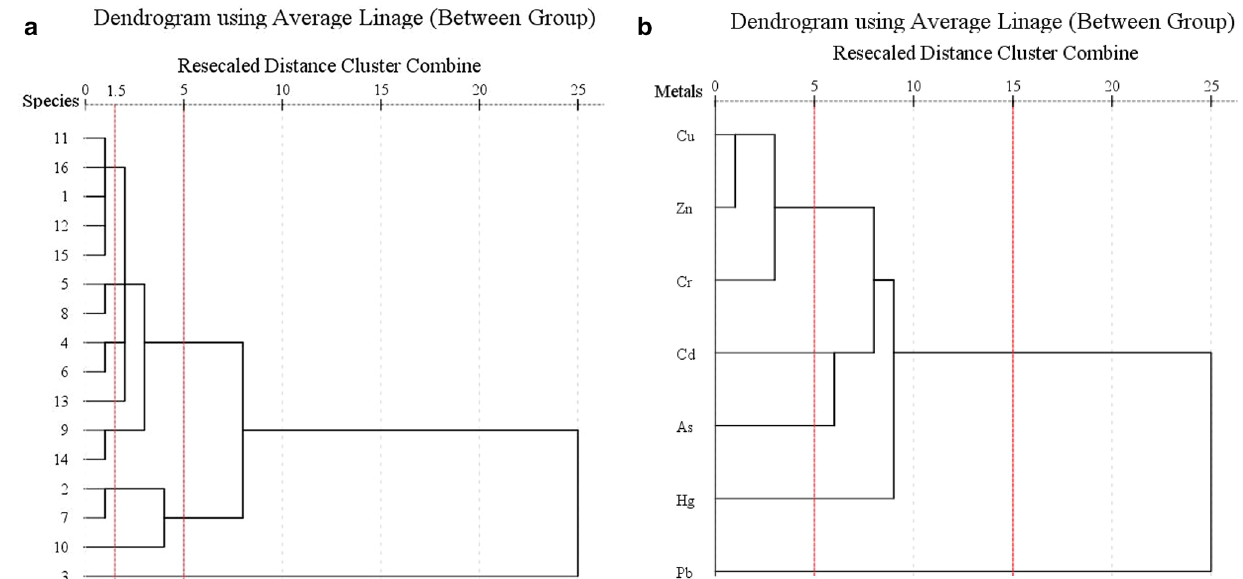
Figure 3. Dendrogram showing species similarity, clustered according to seven trace metals ( a ) and metals homology, cluster according to sixteen fish species ( b